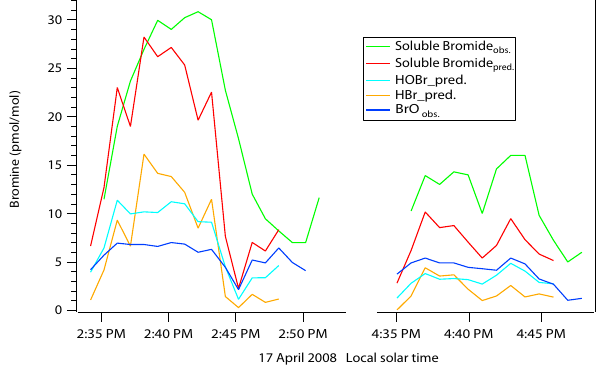
Fig. 3. Example of observed BrO and soluble bromide, and pre- dicted HOBr, HBr and soluble bromide for two marine boundary layer flight legs when the highest levels of BrO and soluble bromide were